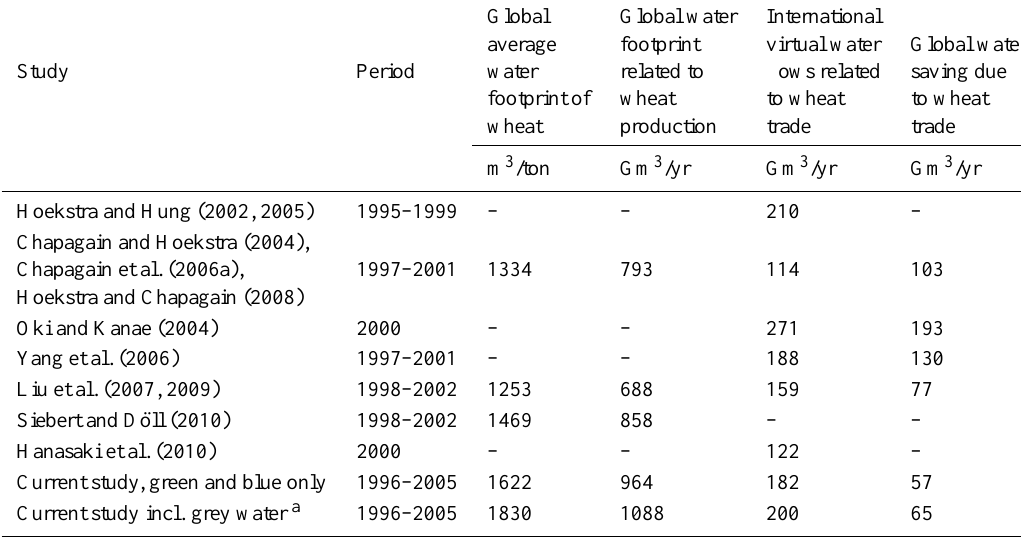
Table 7. Comparison between the results from the current study with the results from previous